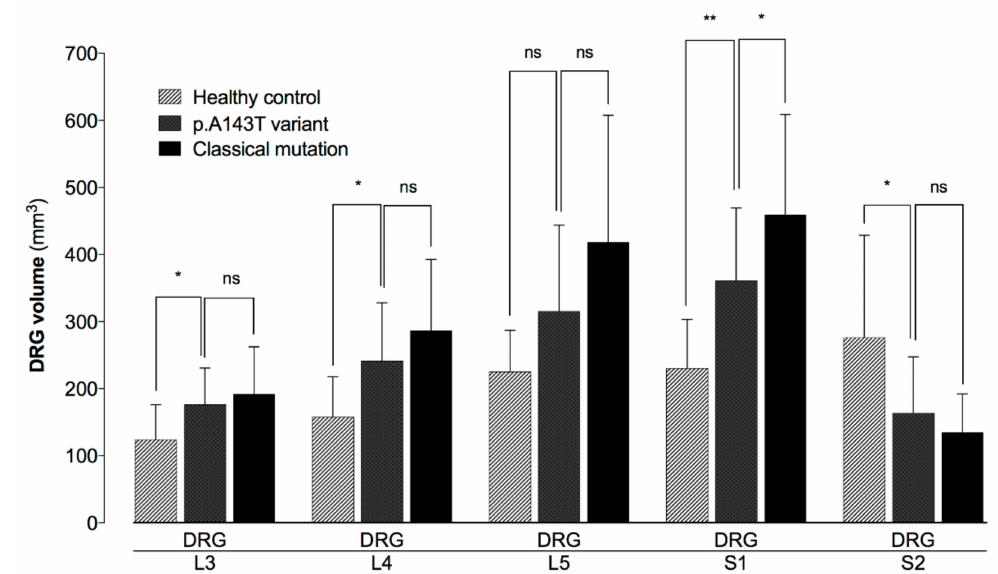
Figure 1. Quantitative assessment of dorsal root ganglia (DRG) volumes L3 trough S2. Mean values of DRG volumes L3 through S2 were calculated level-wise for patients carrying the GLA -gene variant p.A143T, patients with a classical Fabry mutation and healthy controls. Compared to healthy controls, p.A143T carriers showed increased DRG volumes for the level L3, L4, S1, and S2, but less increased compared to patients carrying a classical Fabry mutation (ns non-significant, * p < 0.05, ** p < 0.01).